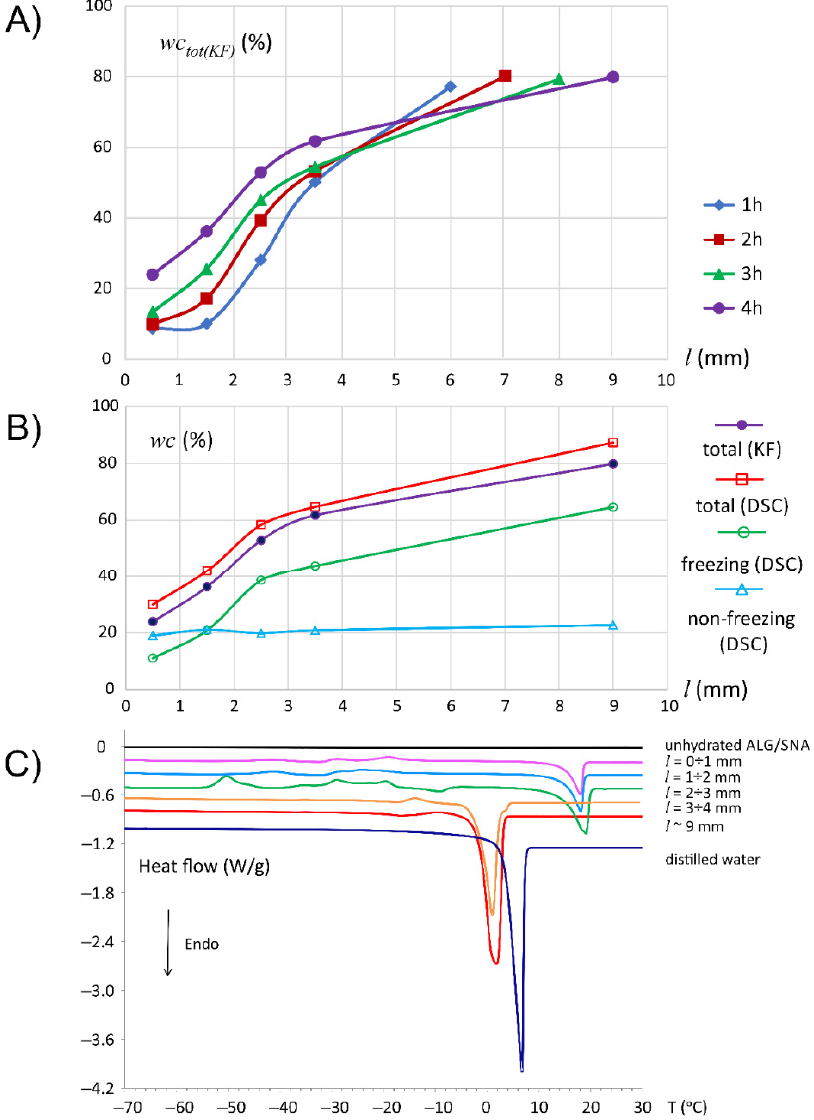
Figure 4. Changes in total water content (wc tot(KF) ) in subsequent ALG/SNA tablet slices at 1, 2, 3 and 4 h of hydration determined by Karl Fischer method—continuous lines serve as visual guide only ( A ); Freezing water content, non-freezing water and total water in tablet slices of the ALG/SNA matrix after four hours of hydration as determined by the DSC method; and total water content (wc tot(KF) ) determined by KF method—continuous lines serve as visual guide only ( B ); DSC heating curves of samples taken from subsequent ALG/SNA slices after 4 h of hydration ( C ).